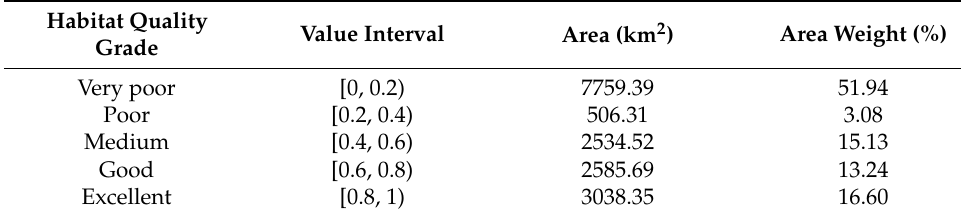
Table 8. Percentage of area and mean value of habitat quality at grades in 2018.